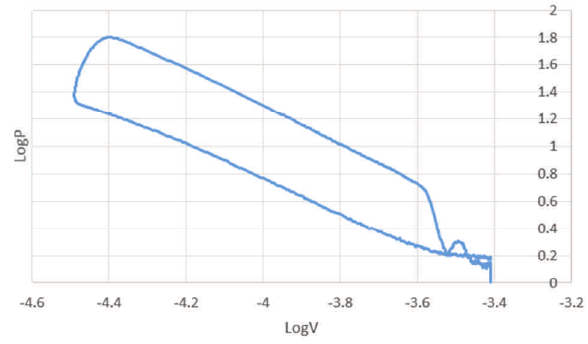
Fig. 4d. Graph of logP against logV